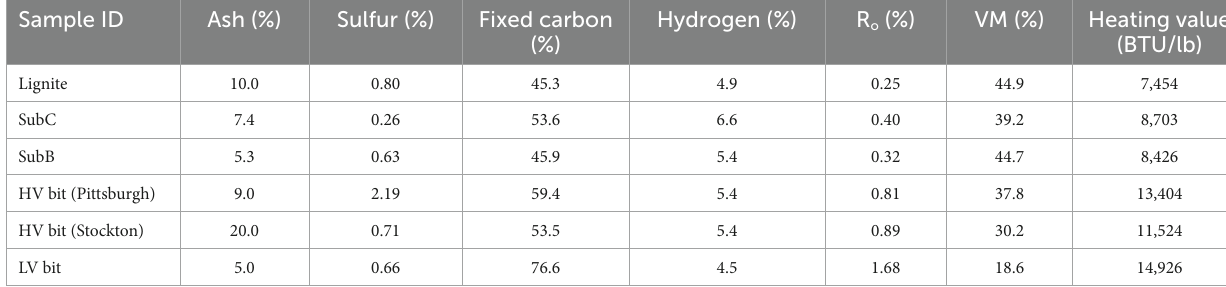
TABLE 2 Elemental and proximate analyses of each coal